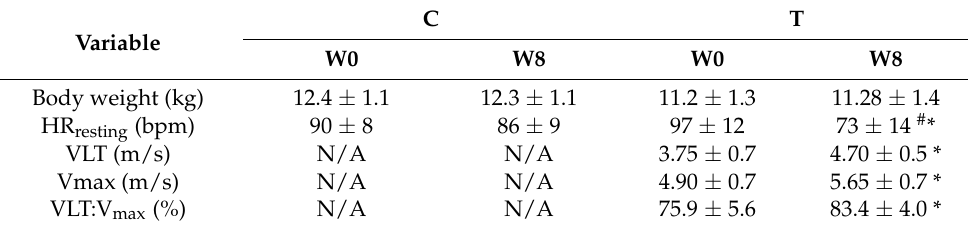
Table 2. Pre- vs. post-training values for body weight, HR resting , VLT, V max , and VLT:V max .